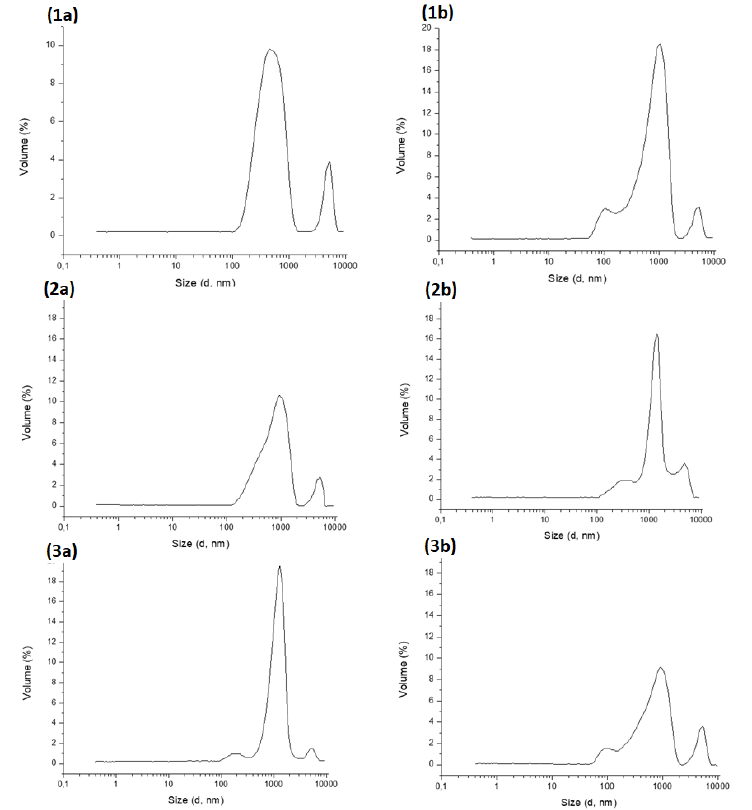
Figure 7. The dynamic light scattering (DLS) footprints from samples from empty and drug-loaded formulations in distilled water ( a ) and simulated gastric fluid SGF pH 3 ( b ): (1) milk chocolate, (2) white chocolate, (3) dark chocolate.